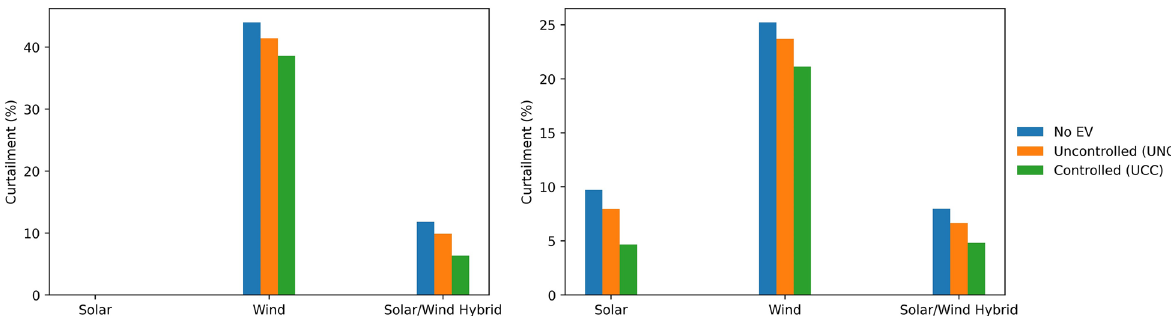
Fig. 11 Total system curtailment for solar, wind, and solar-wind configurations for a the January week (left) and b the July week (right)